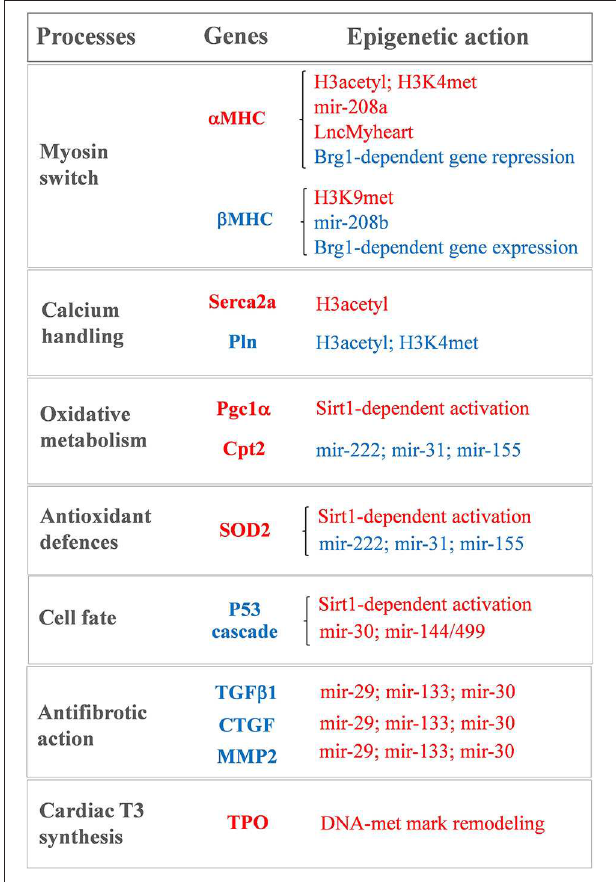
FIGURE 1 | Sketch of the main T3-modulated processes with the corresponding epigenetically regulated genes. In red: genes and epigenetic mechanisms activated by T3. In blue: genes and epigenetic mechanisms inhibited by